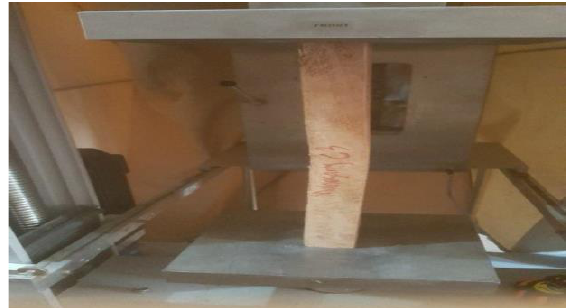
Fig. 3. The failure mode Mahogany (600mm).